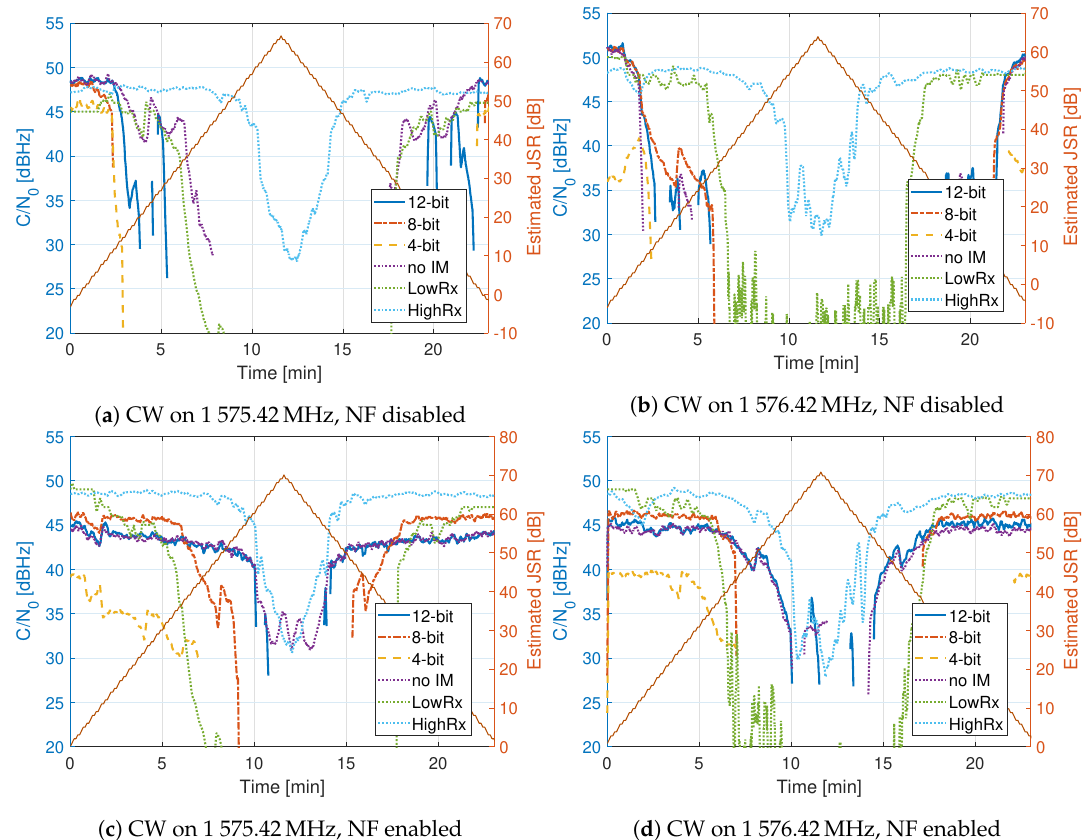
Figure 16. Comparison of tracking